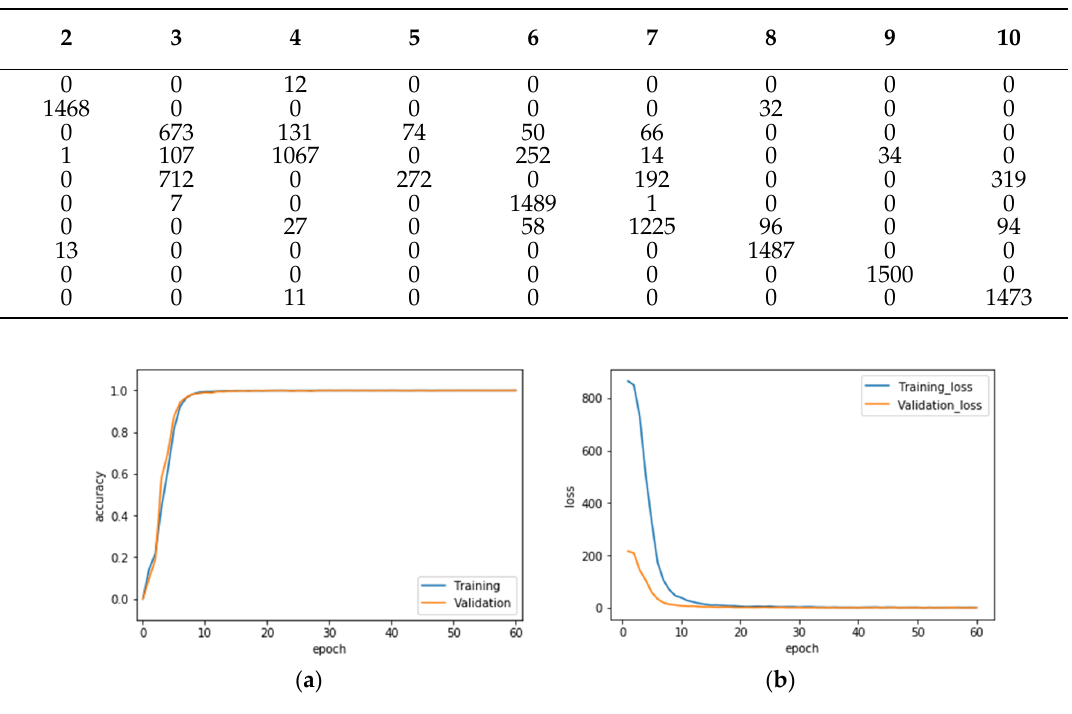
Figure 19. Recognition rate ( a ) and loss value ( b ) curves of the VGG-16 CNN model training using max-min wavelet fused images.